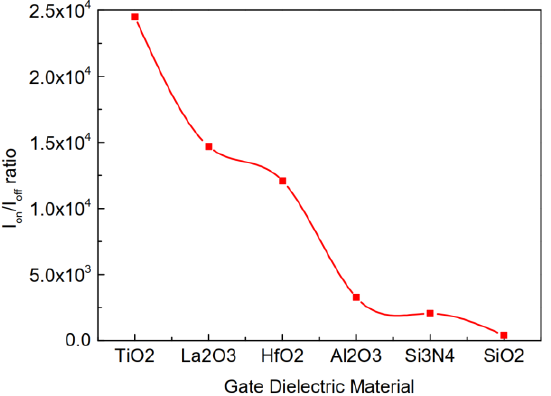
Figure 15. Behavior of the current ratio I on / I off as a function of gate dielectric materials for FinFET devices at V ds = 0.8 V.